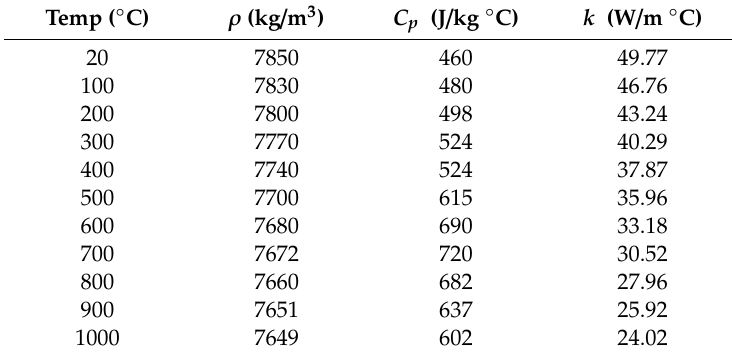
Table 1. Thermal properties of AISI 1045 steel.